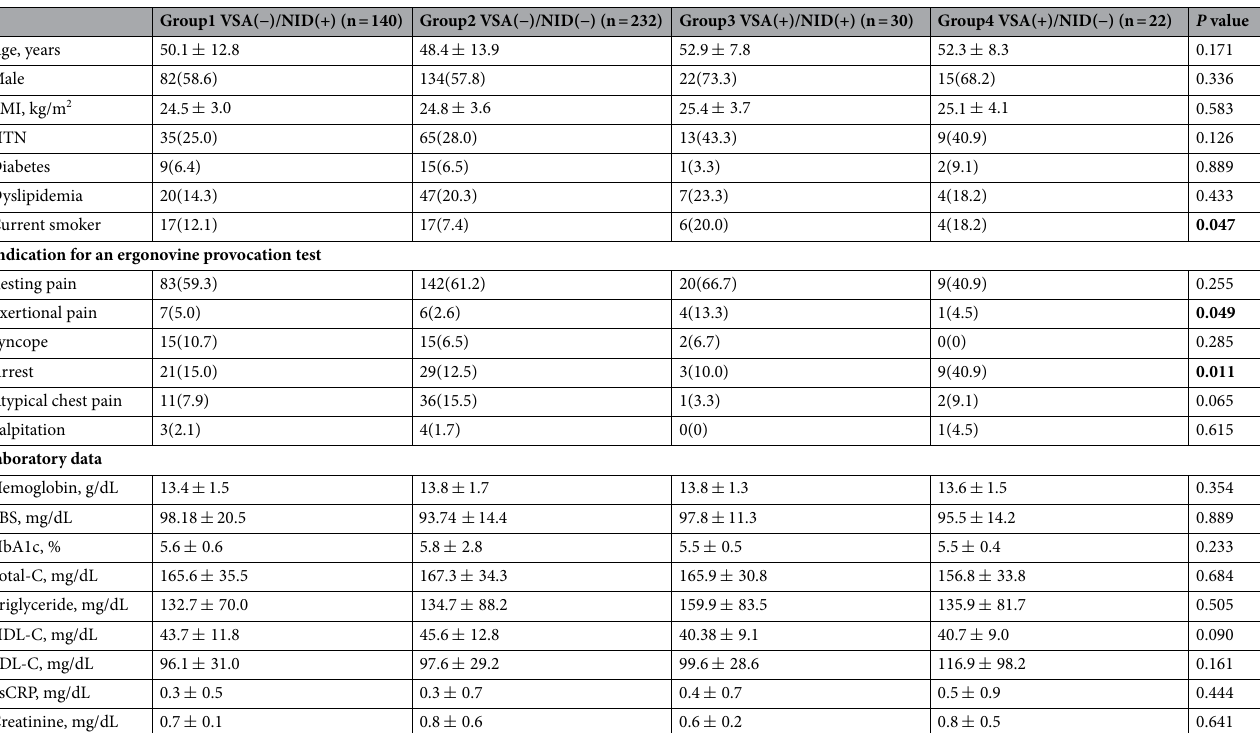
Table 6. Baseline characteristics and indications for an ergonovine provocation test between 4 groups derived from the combinations of VSA and NID results. Data are expressed as numbers (percentages)